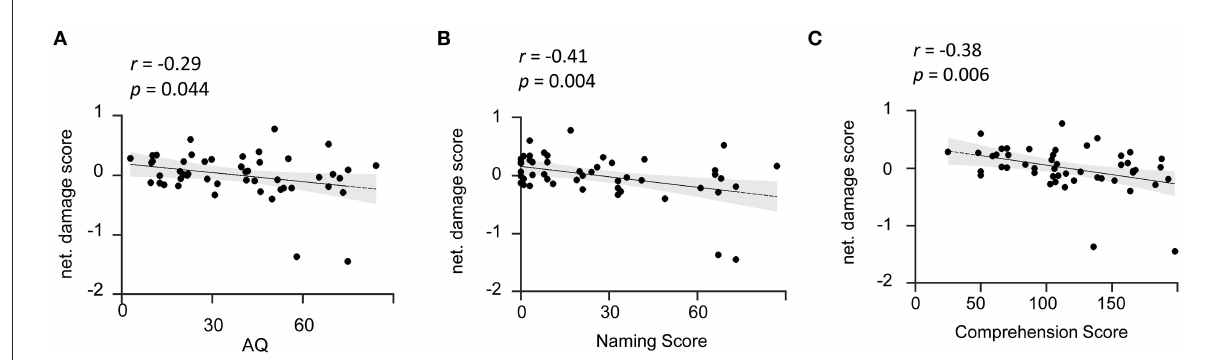
FIGURE4 Damage level of the identified language network is reversely associated with aphasia severity. (A) Network damage level is associated with AQ. The scatter plot illustrates a significant negative correlation ( r = − 0.29, p = 0.044) between network damage scores of the identified language network and patients’ AQ. (B,C) Network damage level is associated with the naming and comprehension subtests. The scatter plots show that the language network damage score is negatively correlated with naming ( r = − 0.41, p = 0.004) and comprehension ( r = − 0.38, p = 0.006) scores. AQ, Aphasia Quotient. The solid line represents the best linear fit with its 95% confidence interval (shaded area). Black dots are individual data points.